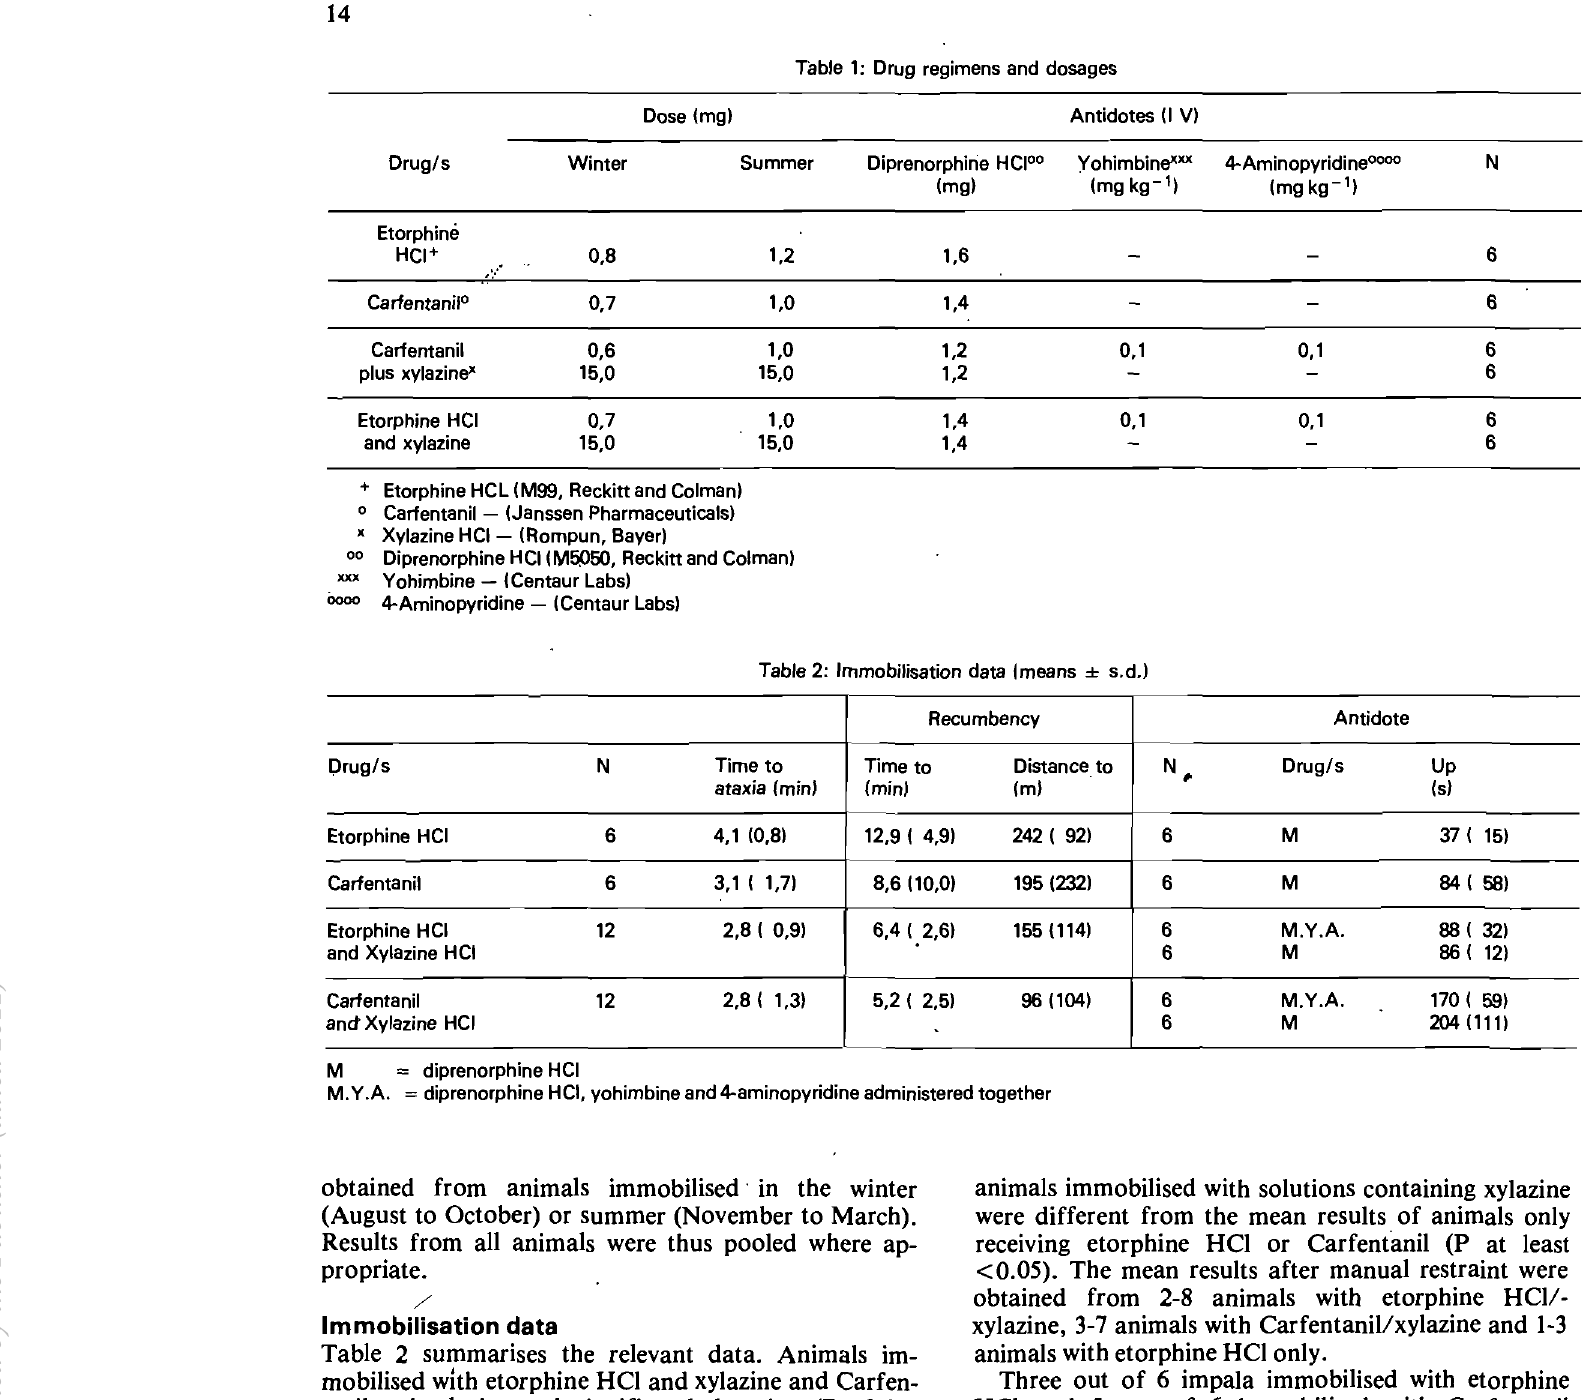
Table 1: Drug regimens and dosages